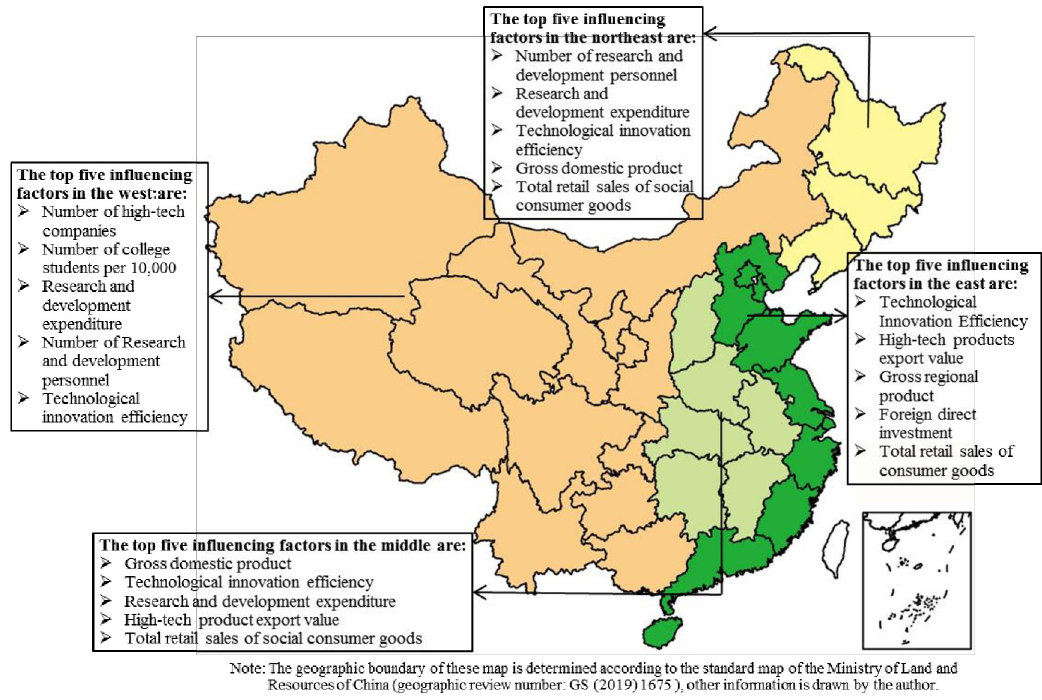
Fig 8. Top five controlling factors of the degree of coupling of composite systems in different regions.